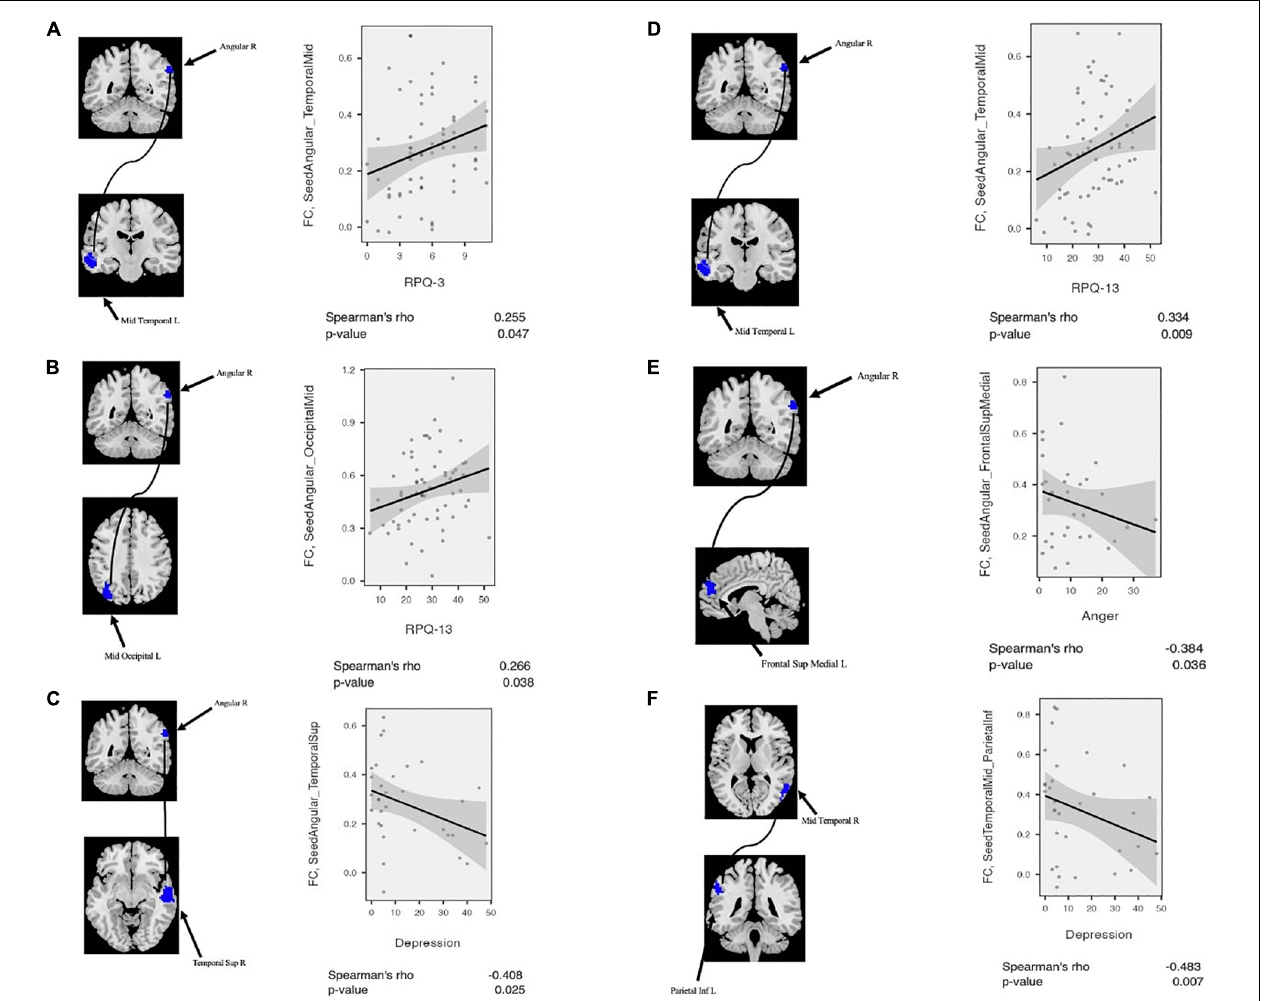
FIGURE 5 | Correlation analysis between altered seed-based functional connectivity (FC) and neuropsychological scores among mTBI patients. (A) RPQ-3 is positively correlated with altered connectivity between Angular_R and Temporal_Mid_L. (B) RPQ-13 is positively correlated with altered connectivity between Angular_R and Temporal_Mid_R. (C) Depression score from POMS is negatively correlated with altered connectivity between Angular-R and Temporal_Sup_R. (D) RPQ-13 is positively correlated with altered connectivity between Angular_R and Temporal_Mid_R. (E) Anger score from POMS is negatively correlated with altered connectivity between Angular_R and Frontal_Sup_Medial_L. (F) Depression score from POMS is negatively correlated with altered connectivity between Temporal_Mid_R and Parietal_Inf_L. POMS, profile of mood